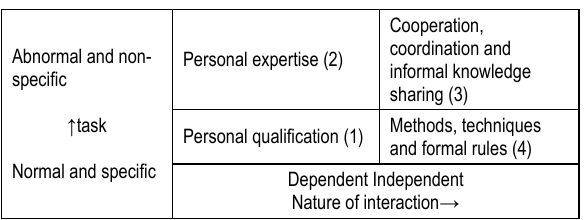
Table 1. The relationship between individual knowledge and organizational knowledge in view of